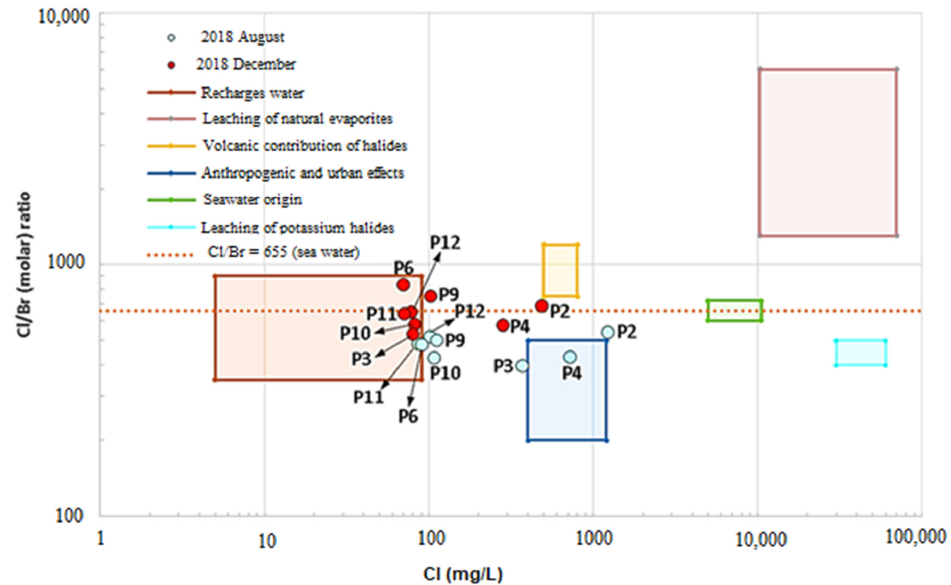
Figure 4. Cl/Br ratio of the groundwater samples of the Manglaralto river basin in August 2018 and December 2018.